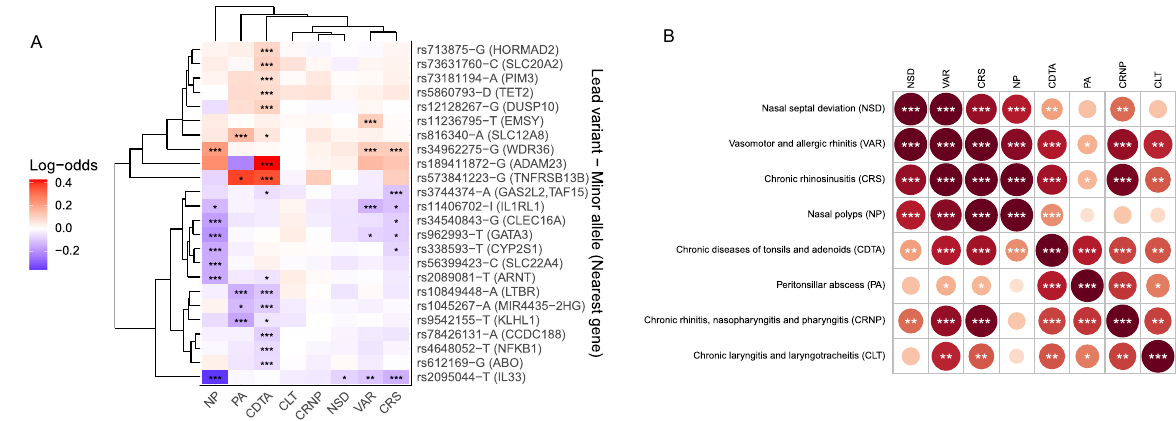
CRS, NP) and pharyngeal diseases (CDTA, PA). * p <0.00027, ** p <5e-8, *** p <5e-9. B (right): genetic correlation of IURDs distinguishing vasomotor and allergic rhi- nitis (VAR), chronic rhinosinusitis (CRS), and nasal polyposis (NP) as a near- completely genetically correlated cluster. The color of the circle indicates genetic correlation with red indicating positive correlation and blue indicating negative